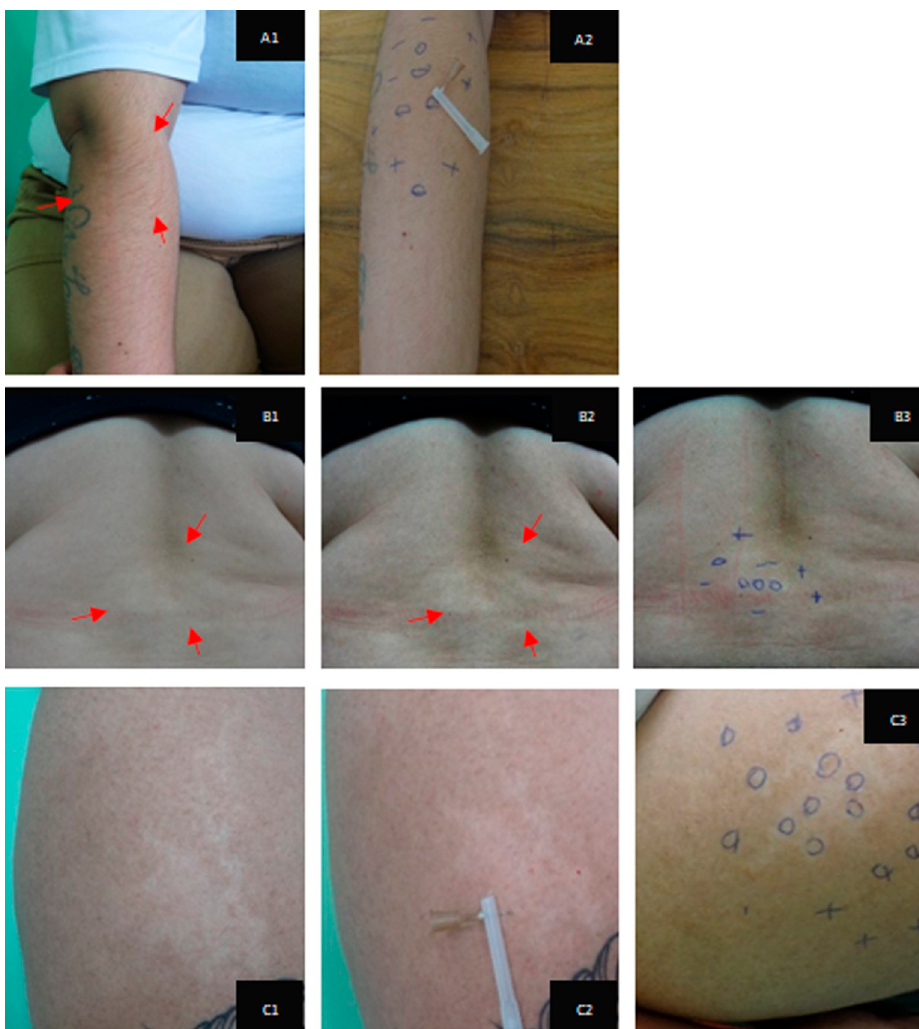
Fig 1. Clinical-dermatological manifestations due to macular alterations of leprosy, effects of the percentage of contrast applied to the digital images and the respective markings of the results obtained in the sensitivity tests applied. Hypochromatic macules showing reduction and loss of tactile, thermal and painful sensitivity. Percent image contrast and marking of the responses to the sensitivity test. Reduction of sensitivity [–]; Absence of sensitivity [0]; Normal sensitivity [+] for: A) right forearm; A1- 20% contrast; A2- anesthesia, tactile and painful sensitivity; B) median lumbar region; B1- original image; B2- 40% contrast; B3- tactile sensitivity; C) anterior region of the right thigh; C2 algic anesthesia; C3- tactile sensitivity.